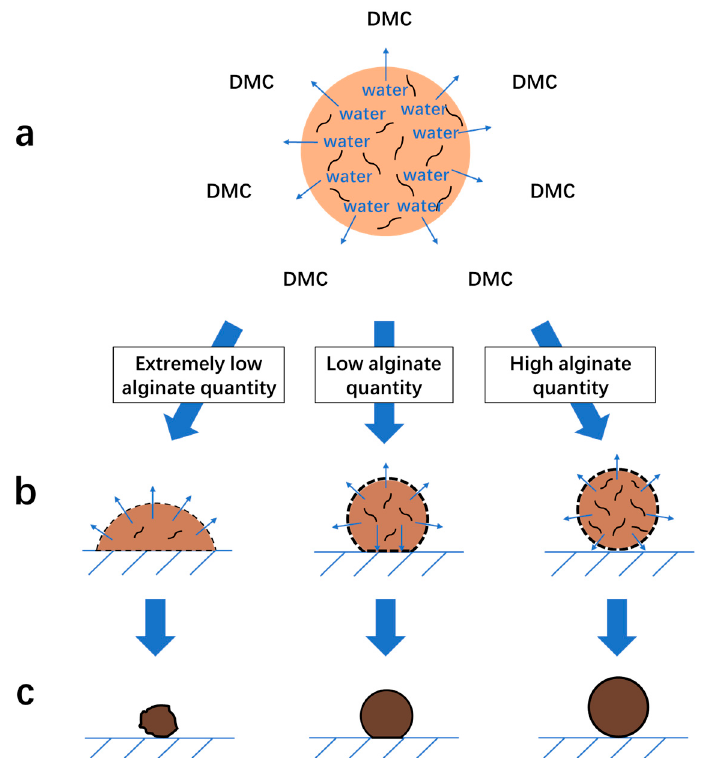
Figure 3. Illustration of the mechanism of the formation of Na-Alg/Fe 3 O 4 microparticles in a glass Petri dish filled with DMC: ( a ) droplets fall with water diffusion; ( b ) droplets land on the glass bottom with a primary shell formed on the surface; ( c ) water diffusion reaches equilibrium and final microparticles are formed.